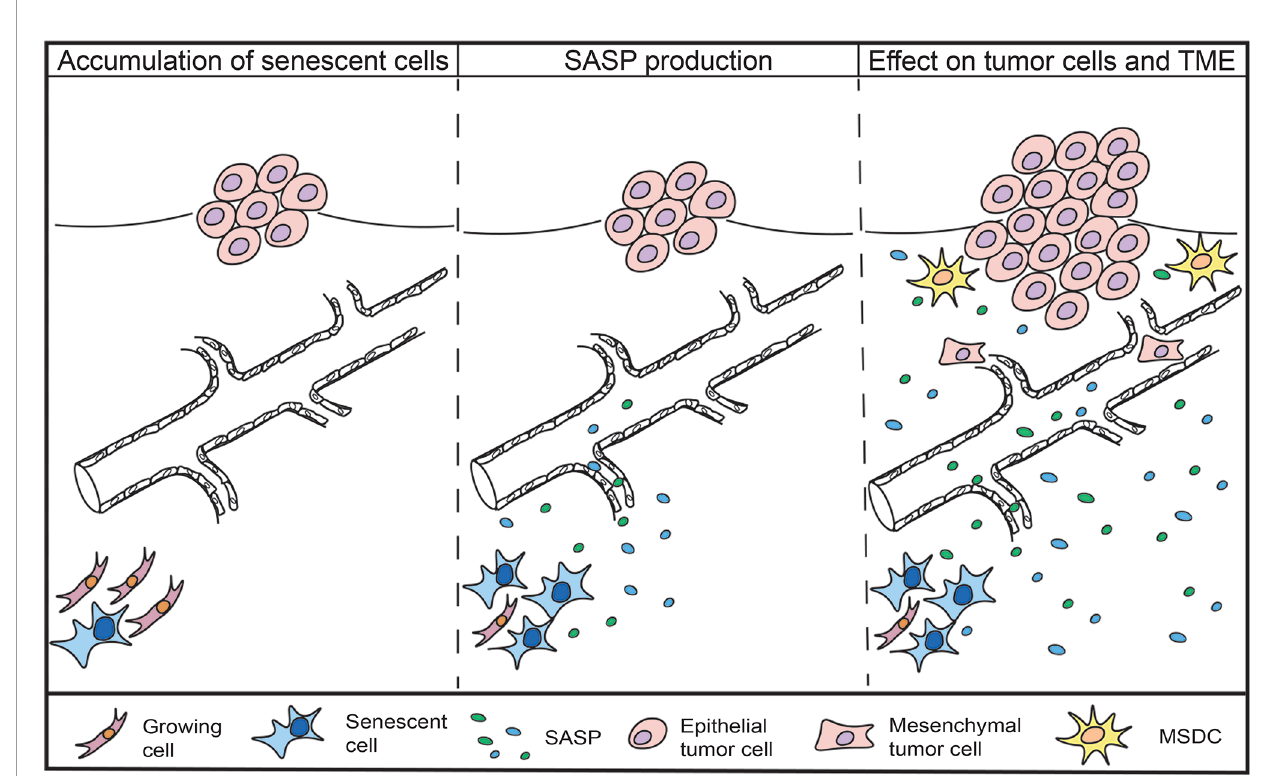
FIGURE 1 | Accumulation of senescent cells and the impact of the SASP on cancer cells and TME. Senescent cells are found to accumulate in aged and obese individuals, as well as in cancer patients that receive chemotherapeutic treatment. Senescent cells remain metabolically active and secrete a combination of in fl ammatory agents, growth factors and proteases, collectively known as the senescence-associated secretory phenotype (SASP). The SASP can promote the proliferation of tumor cells, induce epithelial-to-mesenchymal-transition, recruit immunosuppressive cells and increase the emergence of cancer stem